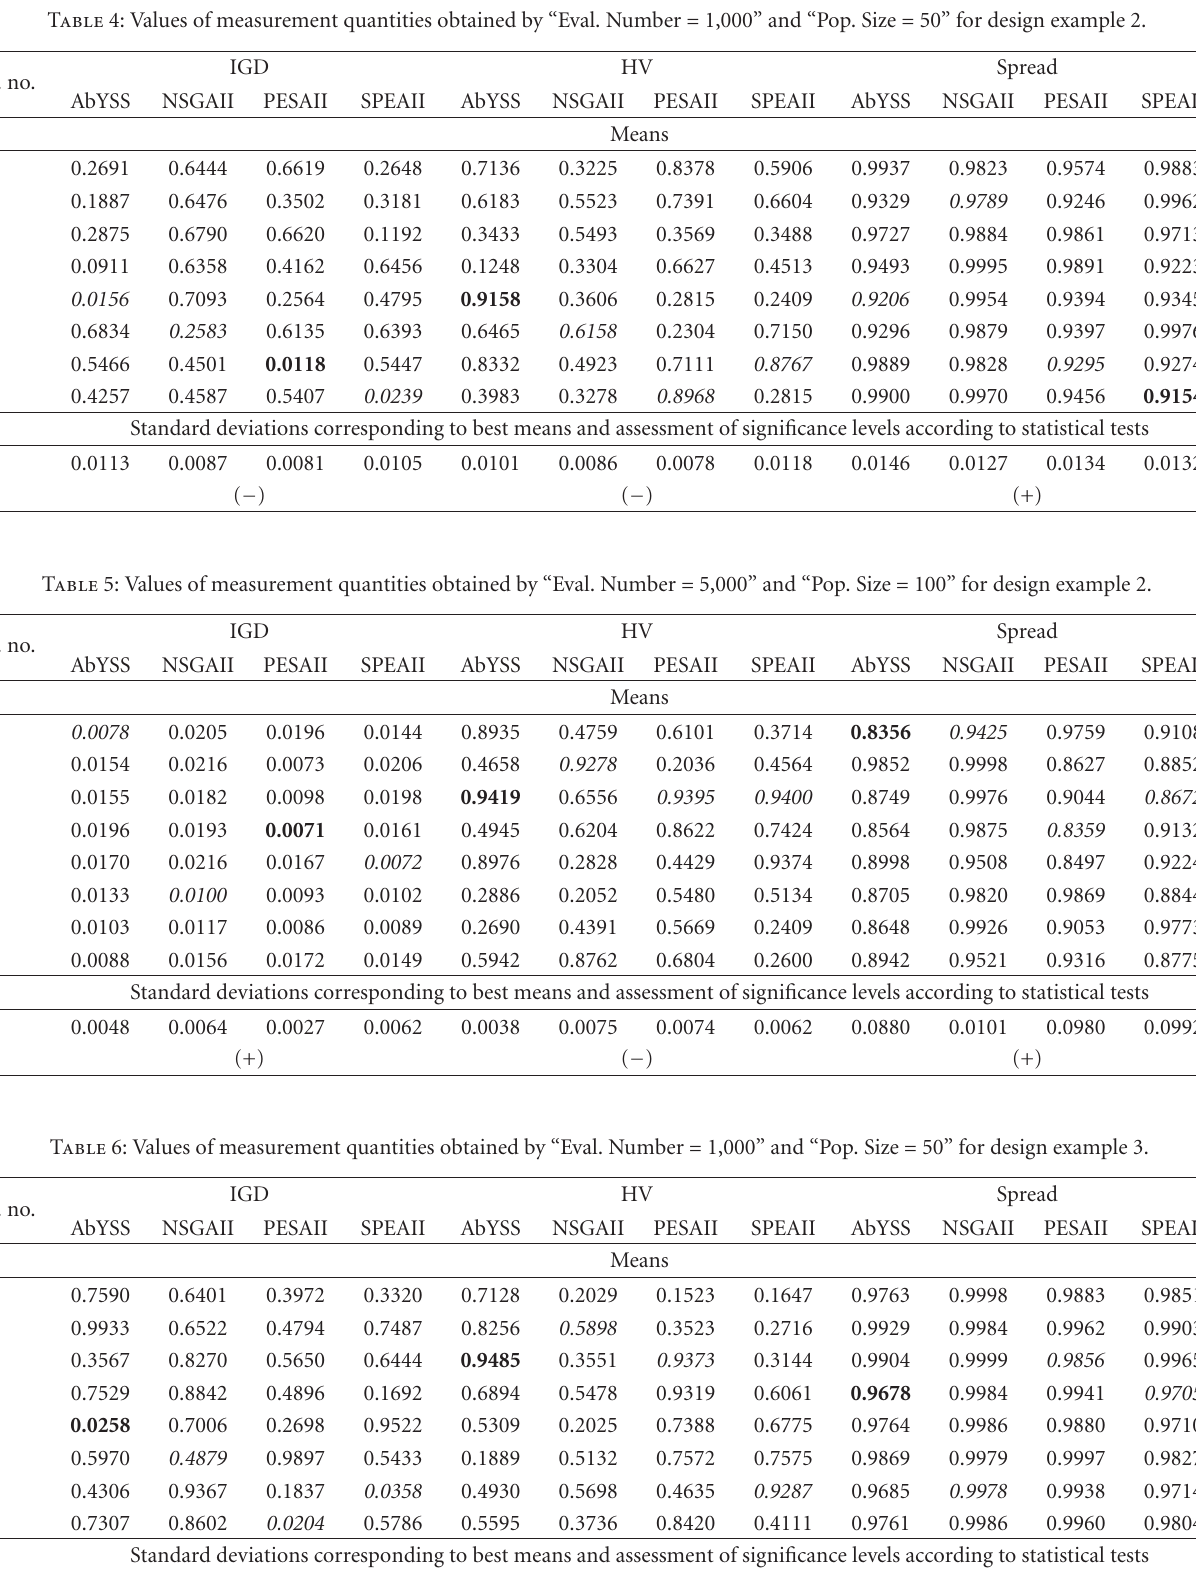
Table 4: Values of measurement quantities obtained by “Eval. Number = 1,000” and “Pop. Size = 50” for design example 2. C. no.